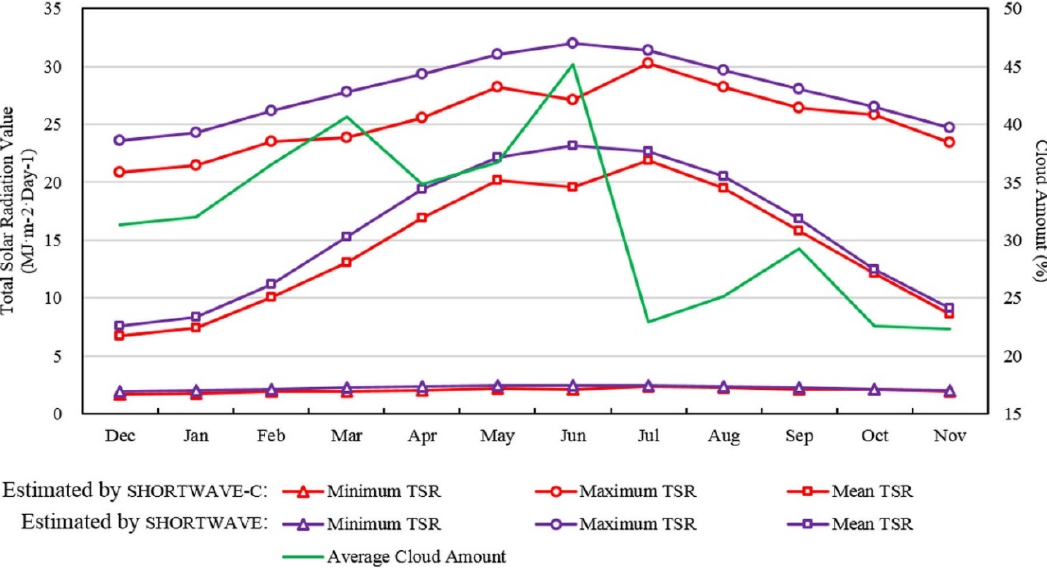
Figure 5. Monthly average total solar radiation simulated by SHORTWAVE-C and SHORTWAVE models, and monthly cloud amount in the Lujiazui region.